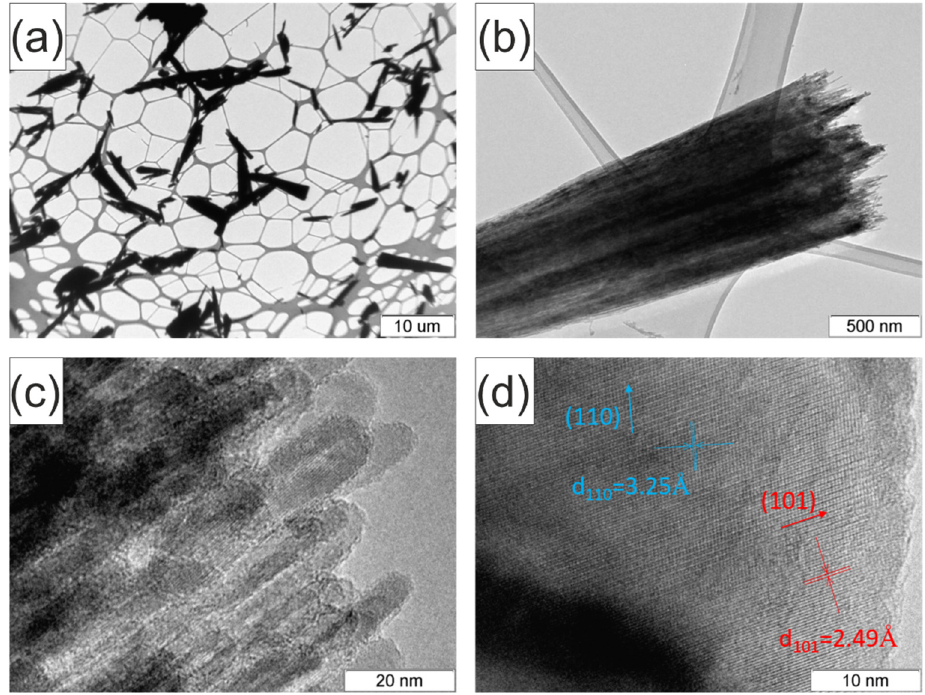
Figure 4. TEM images of r ‐ TiO 2 spherulites at different magnifications at different magnifications: